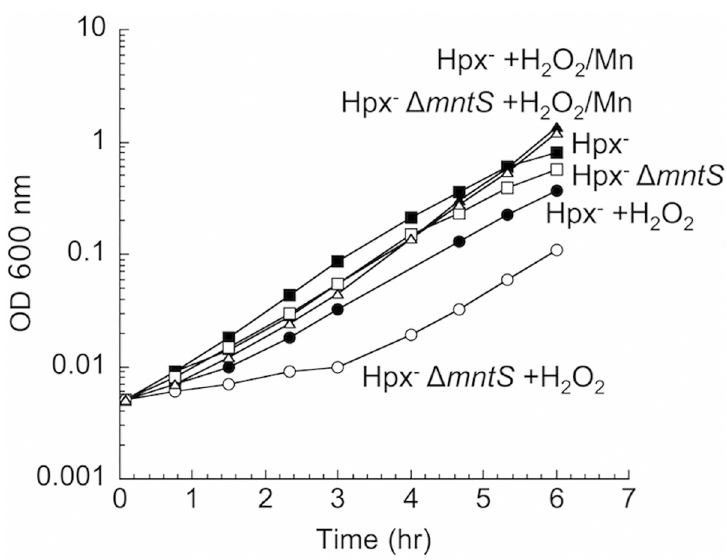
Fig 1. MntS confers resistance to hydrogen peroxide upon manganese limitation. Cells that cannot scavenge H 2 O 2 (Hpx - ) were pre-cultured in anoxic M9 glucose/casamino acids medium and then diluted at time zero into aerated medium of the same composition. Where indicated, 15 μ M H 2 O 2 and/or 5 μ M MnCl 2 were included in the aerated medium. Strains were LC106 (Hpx - ) and JEM1177 (Hpx - Δ mntS ). The data are representative of at least three independent